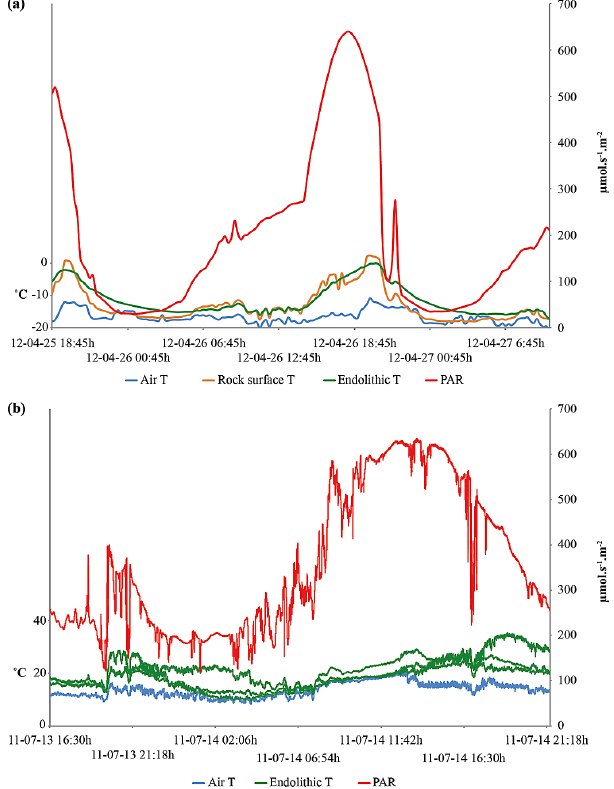
Fig. 3. Microclimate data collected at the field site, including air temperature, rock surface temperature, endolithic temperature and photosynthetically active radiation (PAR). (a) 15min averaged data collected in April 2012. Both rock surface and subsurface tempera- tures are higher than air temperature due to solar radiation that heats rock surfaces. (b) 1s data collected in July 2011. Temperature fluc- tuations result from variability in PAR; however rock temperatures are always higher than air temperature. Variations in endolithic tem- peratures due to data collected from outcrops with different